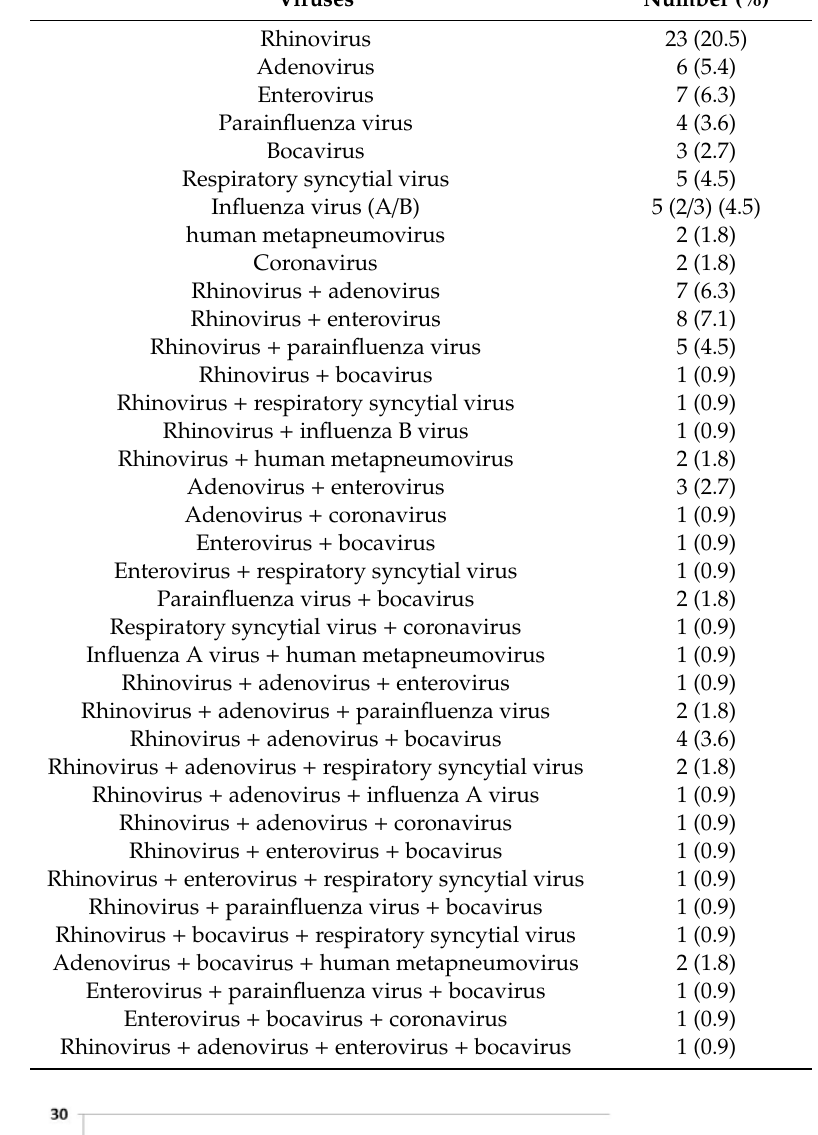
Table 3. Results of multiplex polymerase chain reaction tests for respiratory viruses.